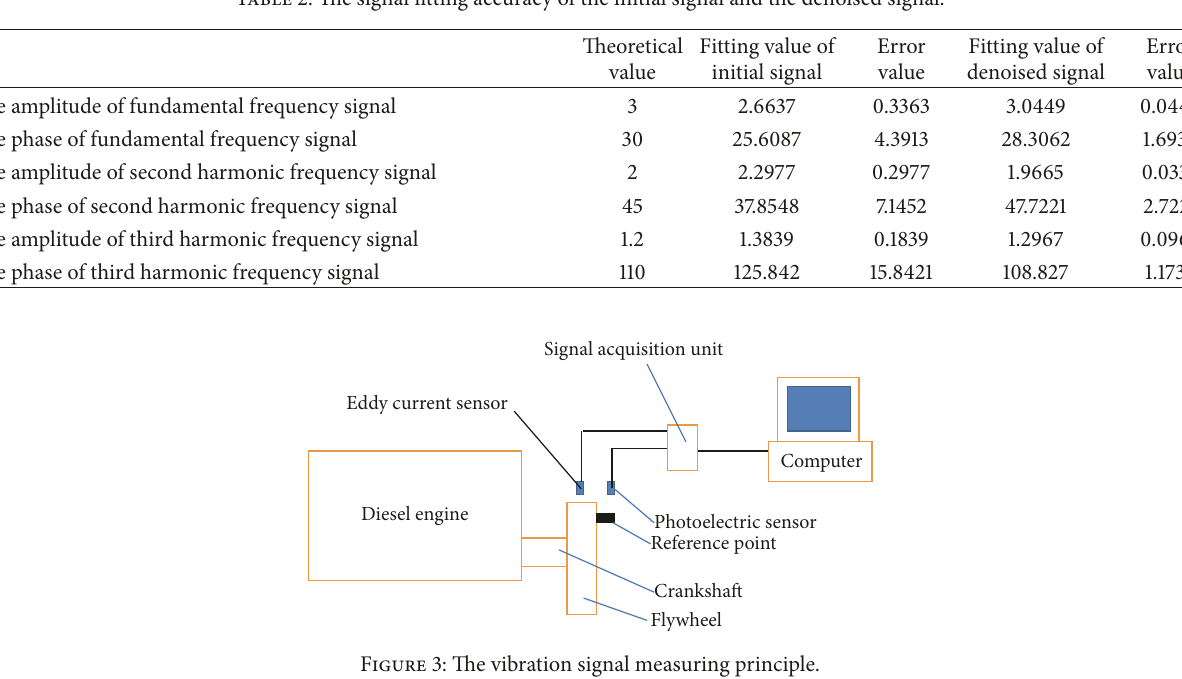
Table 2: The signal fitting accuracy of the initial signal and the denoised signal.